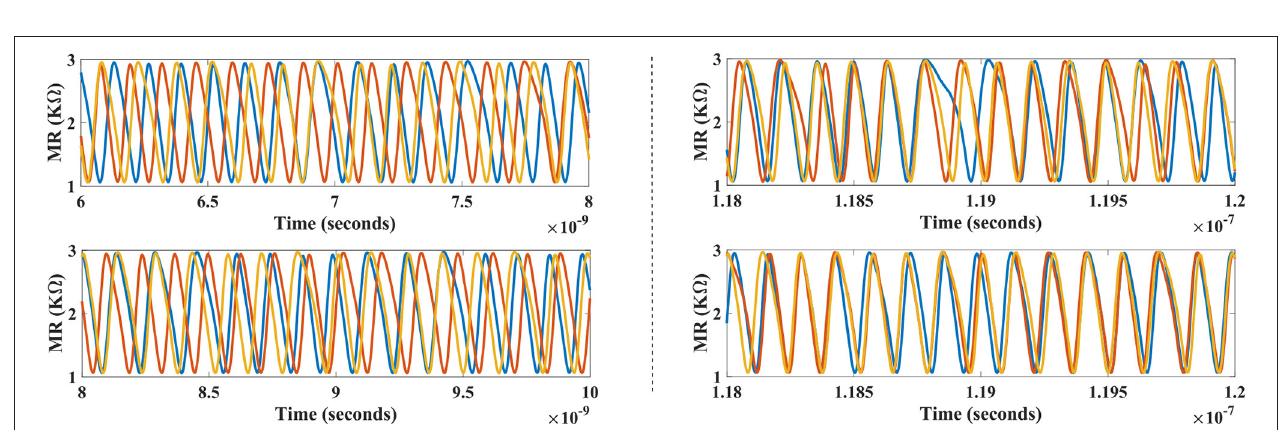
FIGURE 7 | (A) FFT plots for all devices for one of the two possible configurations are shown post-learning. (B) Cross-spectrum phase for devices-pairs 1–3 (178.53 ◦ ), 1-A (3.35 ◦ ), and 1-B (178.3 ◦ ) are plotted to show the phase-locking nature of the network post-learning at the injection frequency of 7.05 GHz.